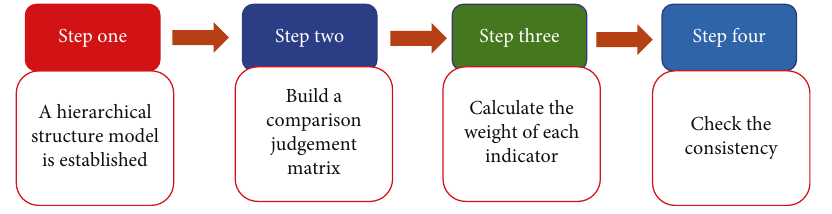
Figure 1: Core steps of analytic hierarchy process. Table 1: Scale